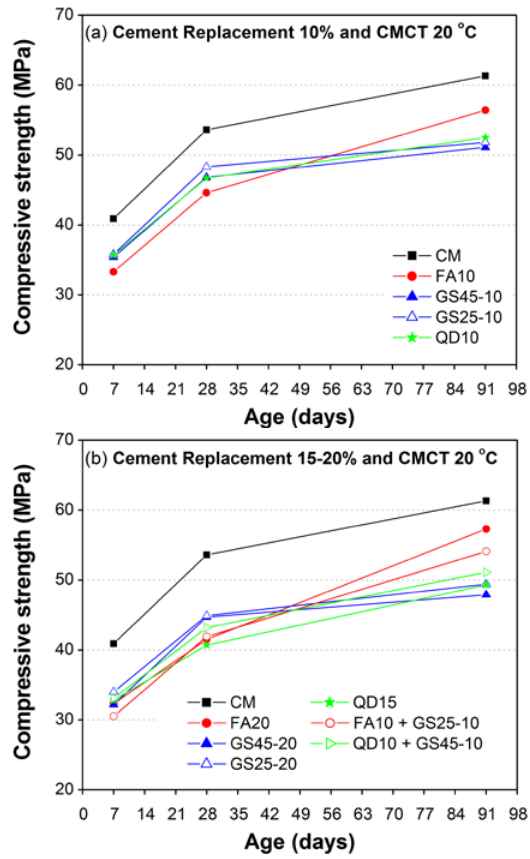
Figure 6. Comparison of the compressive strength development (moist cured under standard curing temperature 20 °C) between CM and mortar containing GS, QD and FA as a partial replacement of cement: ( a ) 10%; ( b ) 15–20%. CMCT, continuously moist cured under a standard curing temperature.